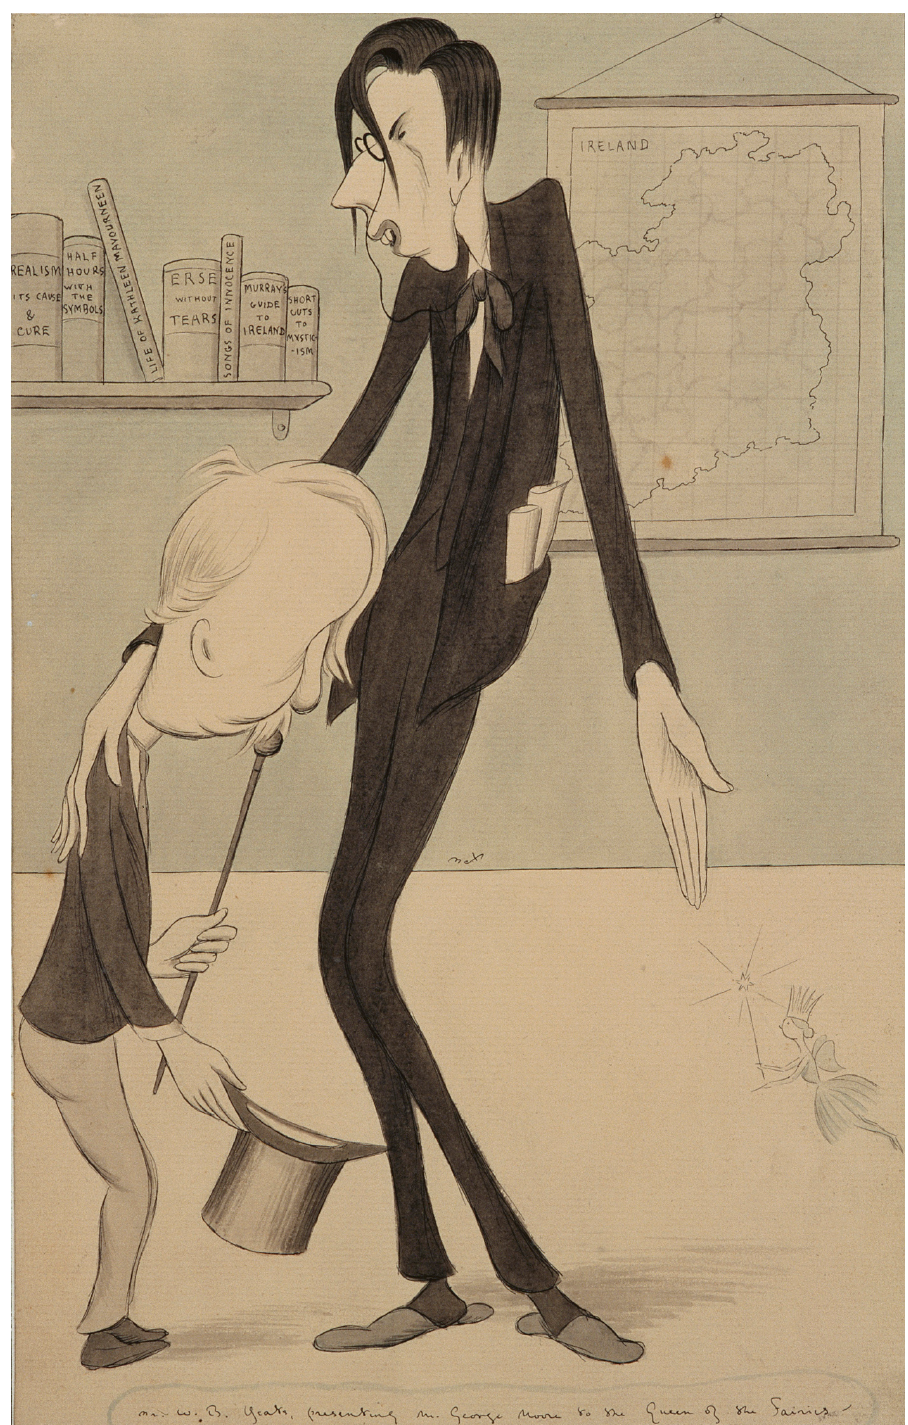
Figure 1 Sir Max Beerbohm, ‘Mr W B Yeats Presenting Mr George Moore to the Queen of the Fairies’ (1904). Collection & image © Hugh Lane Gallery, Dublin (Reg. 71). © The Estate of Max Beerbohm. Yeats’ affection for the fairies was a source of constant ridicule. Note the map of Ireland and books with titles such as Realism: Its Cause & Cure and Short Cuts to Mysticism